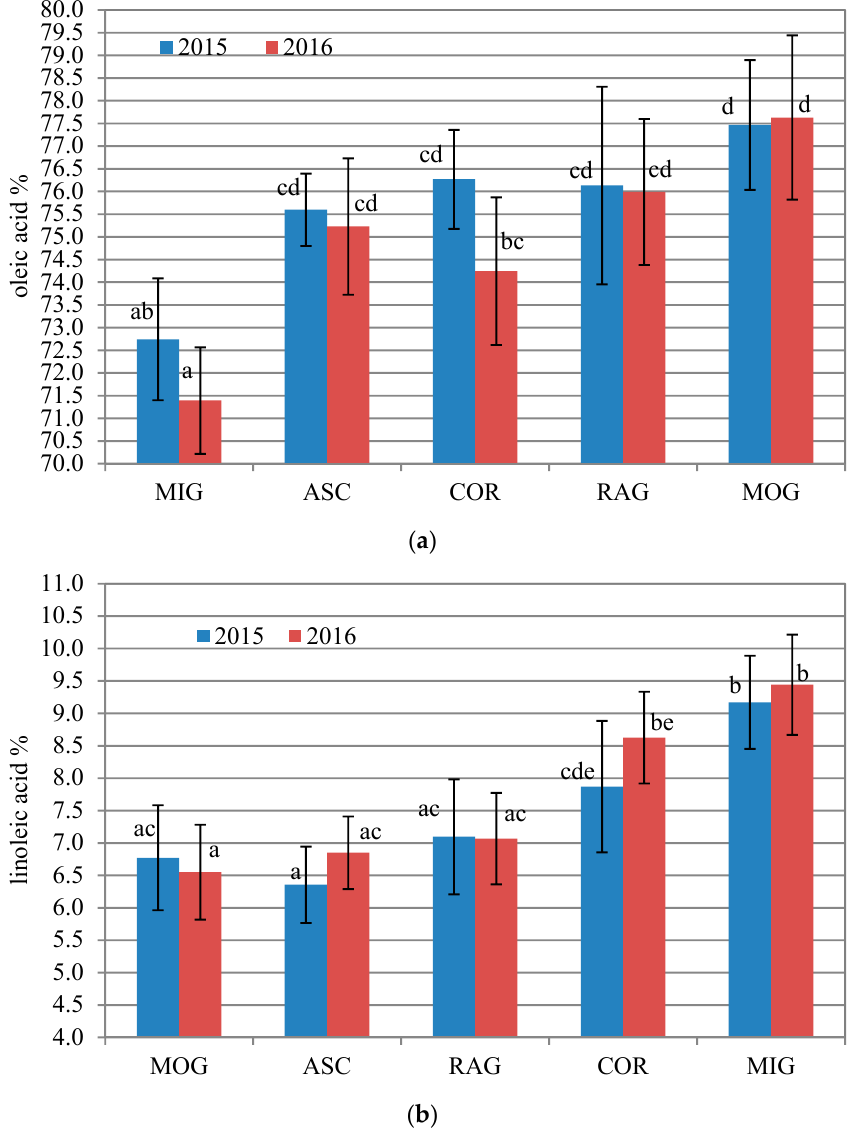
Figure 1. Oleic acid percentage ( a ) and linoleic acid percentage ( b ) in total fatty acid composition in Ascolana tenera (ASC), Coroncina (COR), Mignola (MIG), Piantone di Mogliano (MOG), and Raggia (RAG) monovarietal oils investigated, which was produced in 2015 and 2016. Bars indicate ± standard deviation. All different letters indicate significant differences ( p < 0.05, One-way ANOVA, Tukey’s test for pairwise comparison) among the 10 oil sample groups investigated.